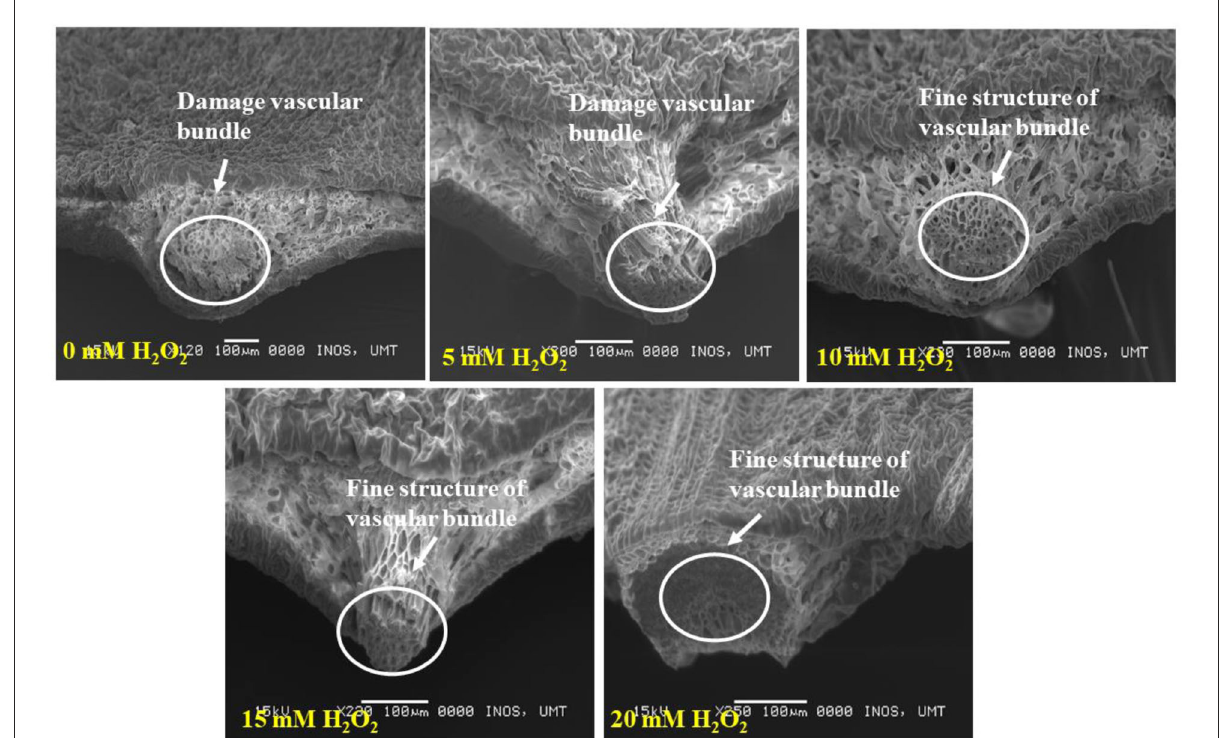
FIGURE7 SEM photographs show the cross section of drought stressed F. deltoidea leaf veins. Fine structure of the vascular bundle (xylem and phloem tissues) is visible in the 10–20mM H 2 O 2 treated plant leaves. Damaged leaf vascular tissues are found in the control and 5mM H 2 O 2 treated